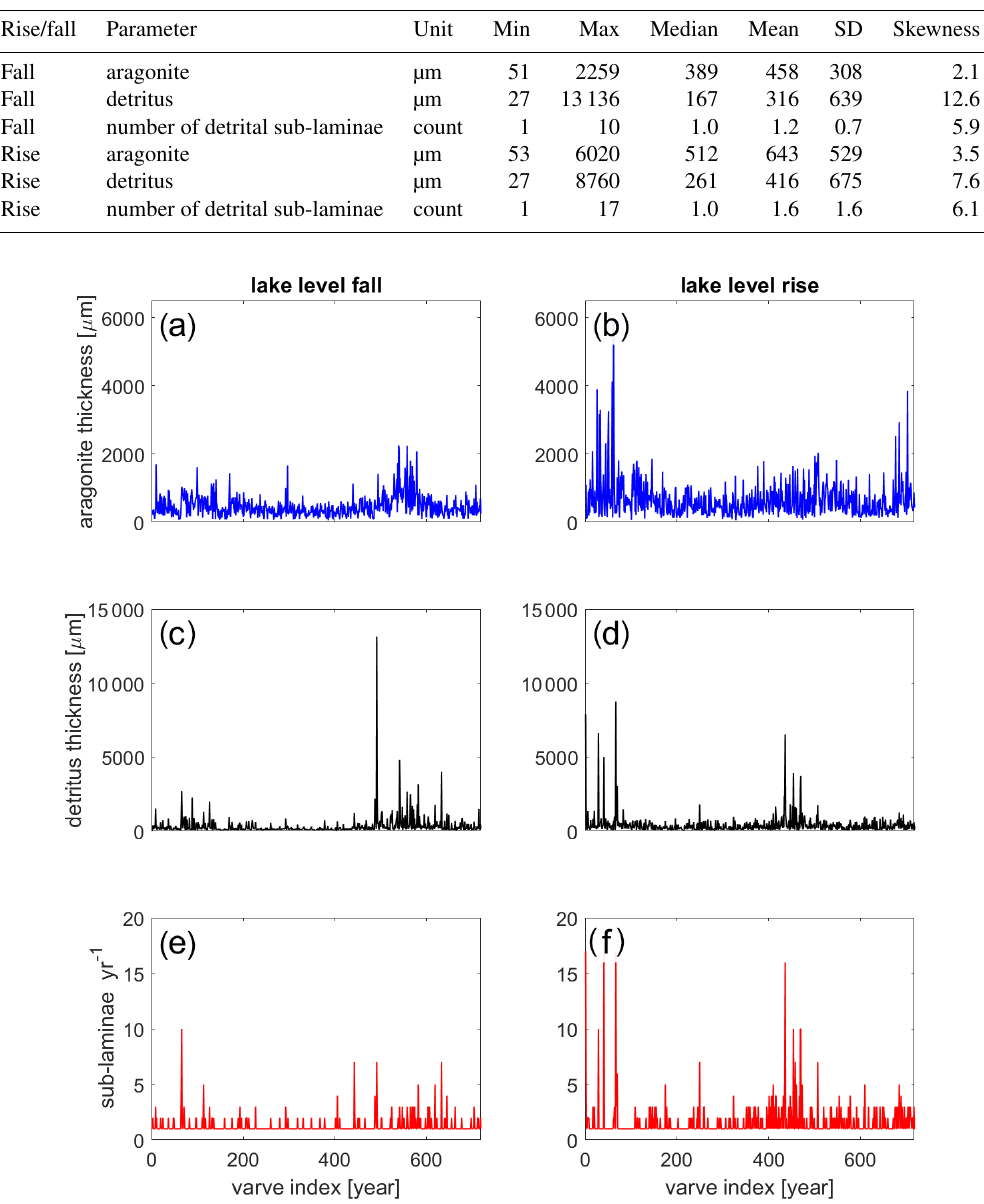
Figure 4. Time series of microfacies analyses of the studied varved sections: ( a , b ; blue) aragonite lamina thickness, ( c , d ; black) detrital lamina thickness, ( e , f ; red) number of detrital